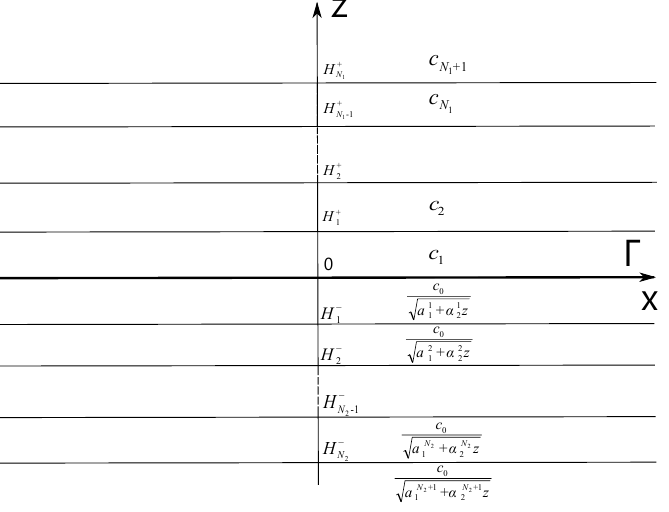
Figure 3. Geometry of the multilayer